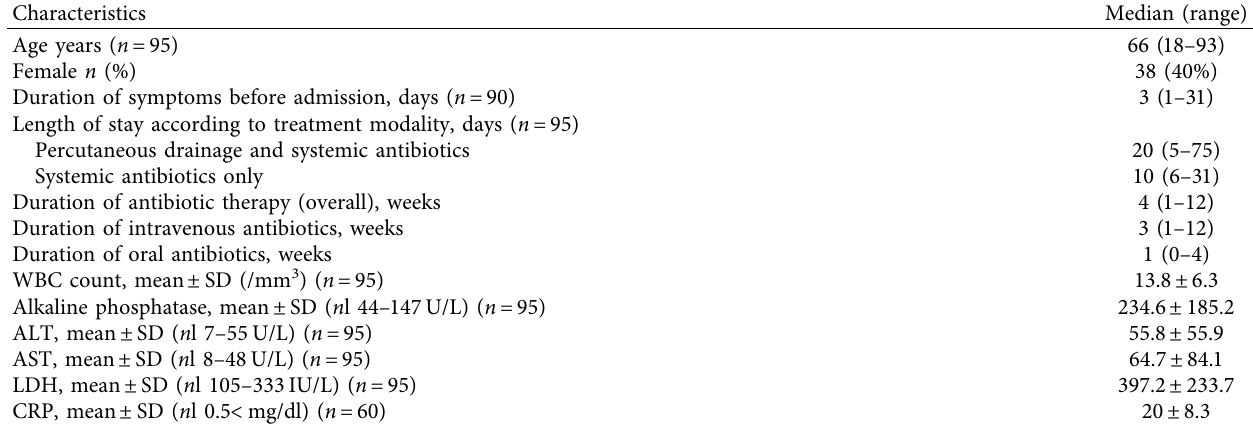
Table 1: Demographic and clinical characteristics of patients with PLA in SZMC 2011–2021.